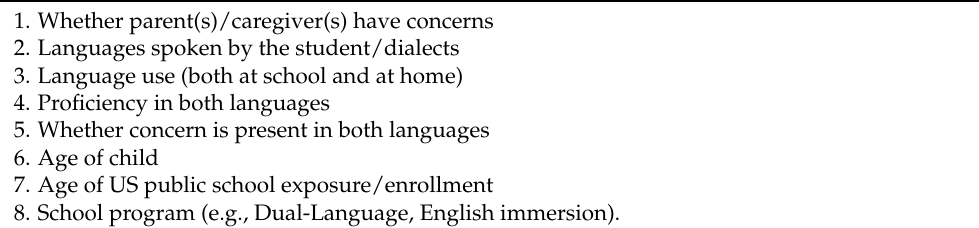
Table 1. Some Initial Considerations for Suspected Language